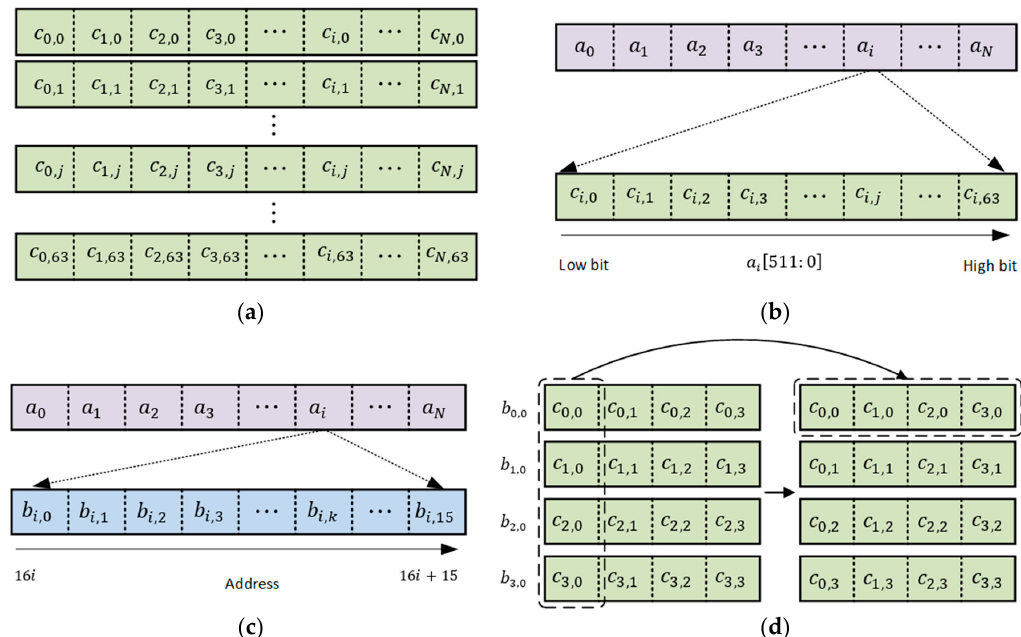
Figure 6. An efficient on-chip storage scheme. ( a ) The order of the ( n + 1)-th layer’s input elements (or the n- th layer’s output elements). c i , j is the element generated by the j- th calculation unit and stored in the i- th address of the output bu ff er. N is the maximum storage address of the output elements;